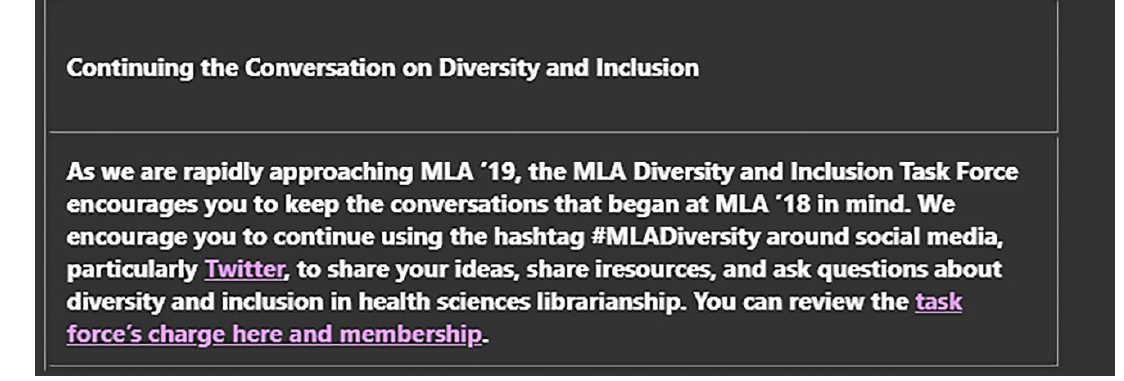
Figure 2 DITF blog post publicizing the Twitter hashtag